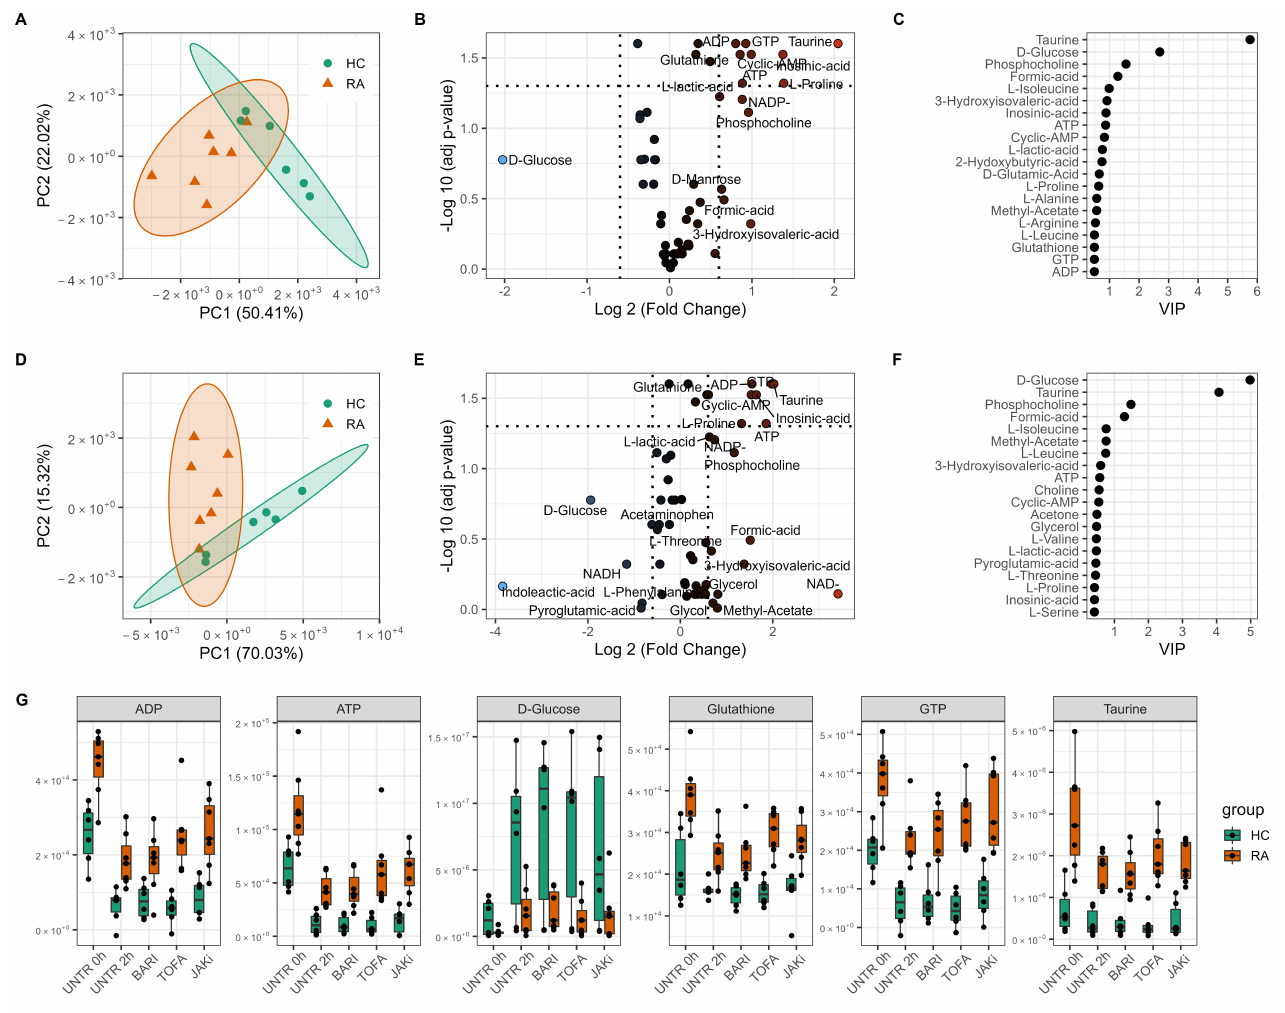
Figure 1. Metabolomics differences between rheumatoid arthritis (RA) and healthy control (HC) neu- trophils . PCA scores plot of HC and RA neutrophils at 0 h ( A ) and 2 h ( D ) showing separation on the first principal component (PC). Volcano plot ( B , E ) showing metabolites significantly different between HC and RA neutrophils (adj p -value < 0.05) and the log2 fold change (FC) for each metabolite as indi- cated by gradient colour scale provided. Variable importance in projection (VIP) ( C , F ) obtained from PLS-DA showing top 20 metabolites for each model. ( G ) boxplot of selected metabolites varying be- tween HC and RA neutrophils with JAK inhibitor treatments (UNTR = Untreated, BARI = Baricitinib, TOFA = Tofacitinib, JAKi = Pan-Jak